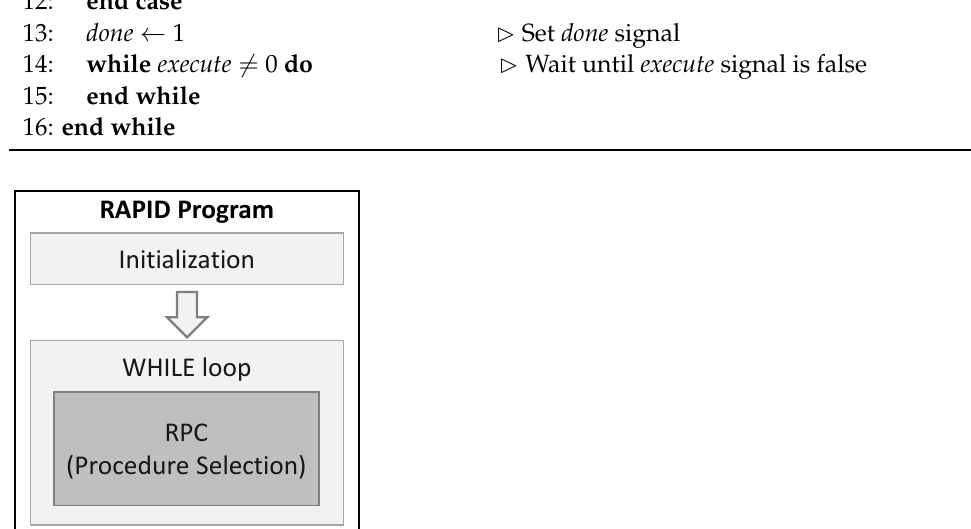
Figure 7. Schematic of the structure of the RAPID program added in the virtual controller of both robots included in the cell.